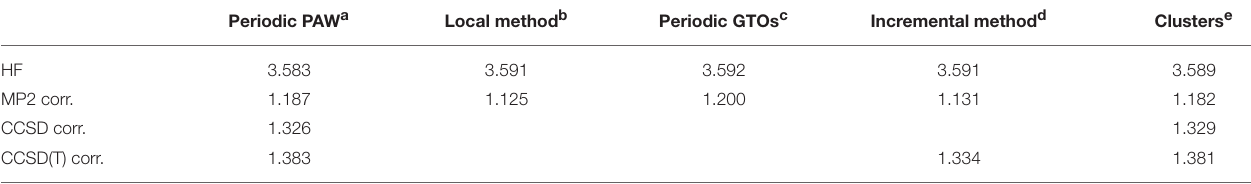
TABLE 1 | Calculated energy contributions to the cohesive energy of the LiH crystal as obtained using different theories and techniques. Periodic PAW a